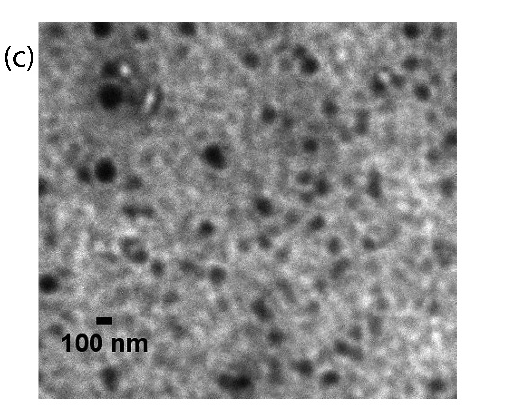
Figure 2. ( a ) MALDI-TOF MS profile: The [M+H] + value calculated for C547H1147N163O83 was 11,336.96 Da and found to be 11,337.344 Da; ( b ) hydrodynamic size distribution pattern; ( c ) TEM image of MTX–G–P 4 LDN–E2 (scale bar: 100 nm).